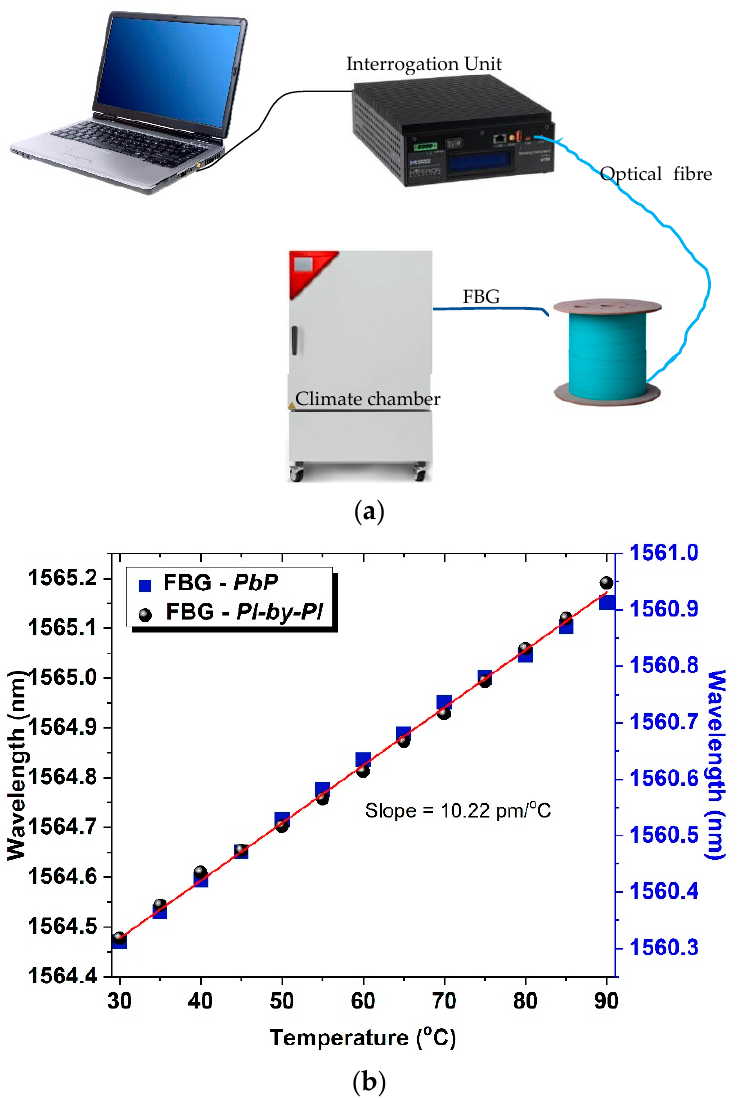
Figure 6. ( a ) Experimental schematic diagram used for the temperature characterisation of the FBGs, ( b ) Temperature response of femtosecond laser-inscribed FBGs using the PlbPl and the PbP method for temperature range of 30 to 90 °C.